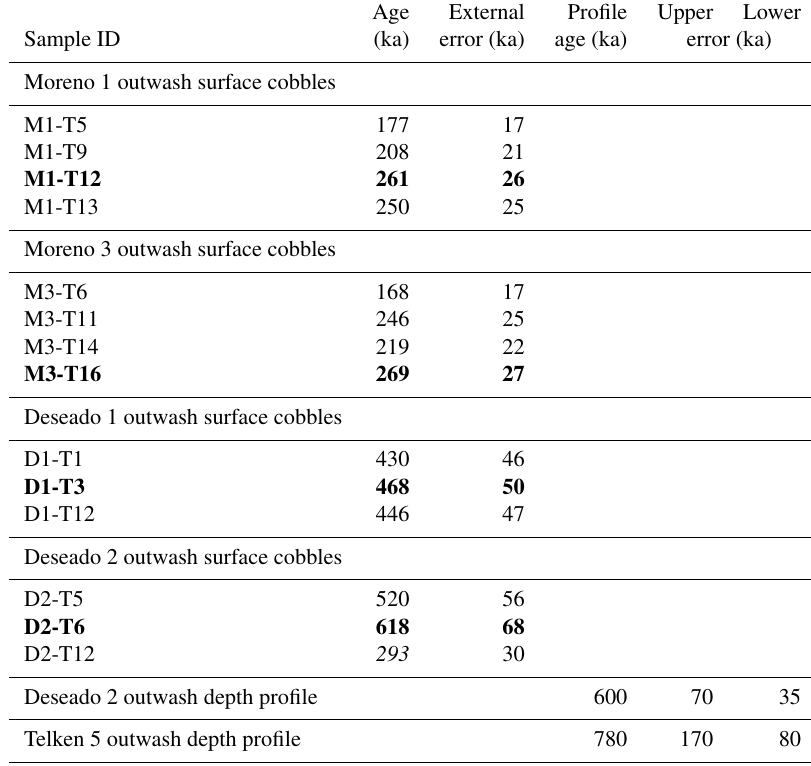
Table 2. Modeled exposure ages for outwash surface cobbles and depth profile samples (see main text and the Supplement for details on profile modeling). Moreno 1 and 3 ages have been already published in Hein et al. (2017). Bold values are the oldest samples for each outwash that we consider to be the most representative deposition age of the moraine (see Sect. 3.1 for